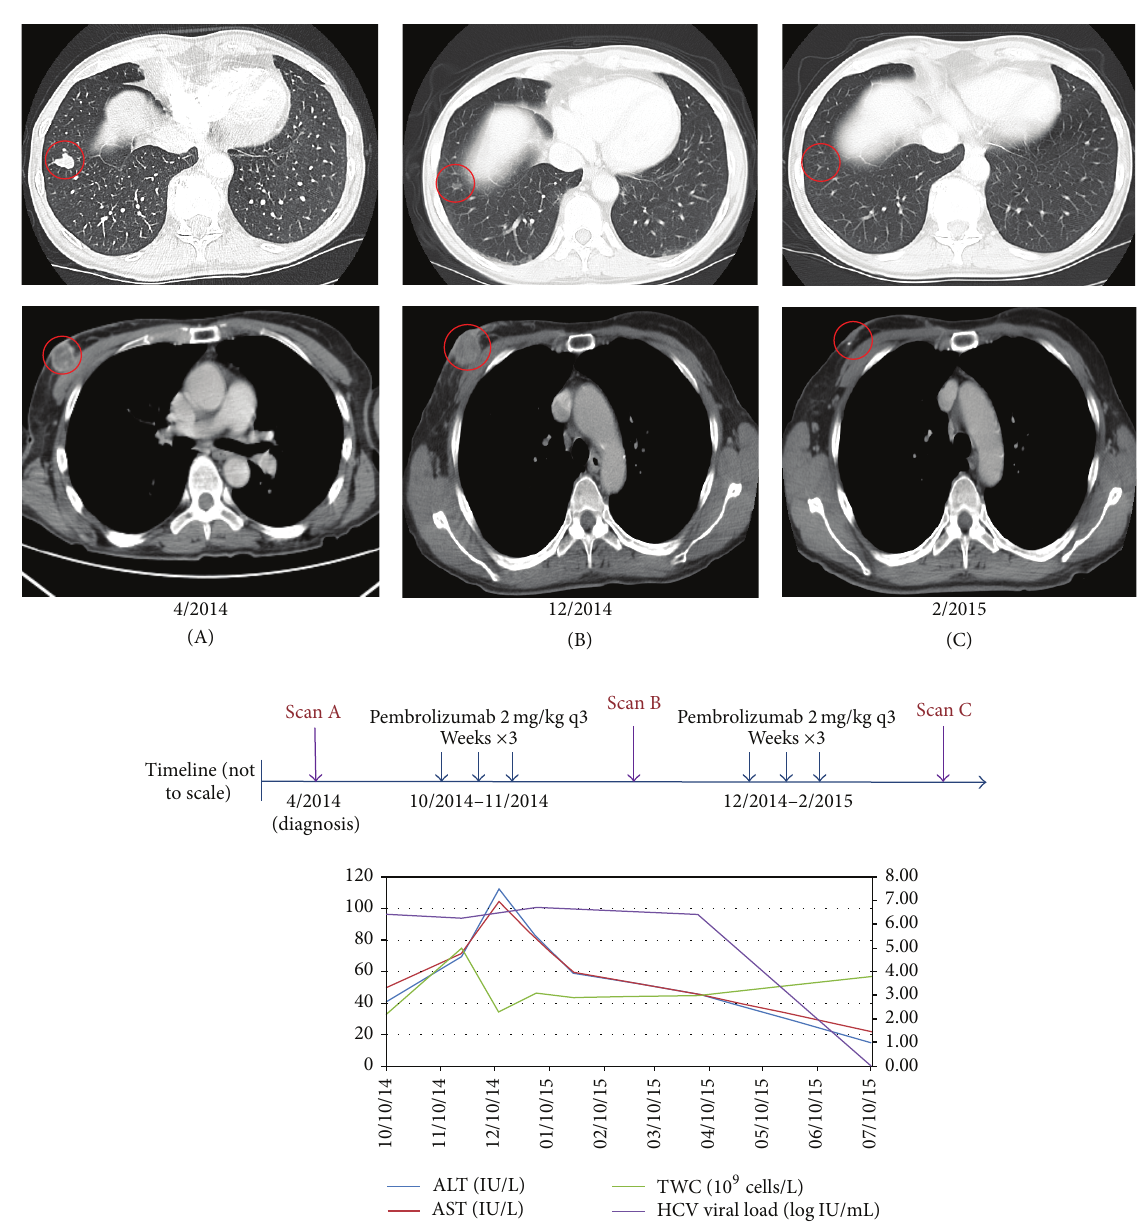
Figure 1: Changes in tumor size and correlation with laboratory results in patient 1. After 3 cycles, index right breast lesion (A-B, lower panel) increased in size while index right pulmonary lesion decreased in size consistent with immune-related response pattern (A-B, upper panel). After 6 cycles, both lesions had decreased in size significantly (C, upper and lower panels). Although pembrolizumab treatment was associated with grade 1 leucopenia and grade 1ALT/AST elevations initially, total white count and ALT/AST levels subsequently stabilized (graph). HCV viral load fluctuated between 3.36 IU/mL (6.53 log IU/mL) and 5.17 IU/mL (6.71 log IU/mL) before initiation of ledipasvir and sofosbuvir in April 2015. After 12-week course, HCV viral load became undetectable and remains so. To date, she has completed 15 cycles to date with ongoing excellent partial